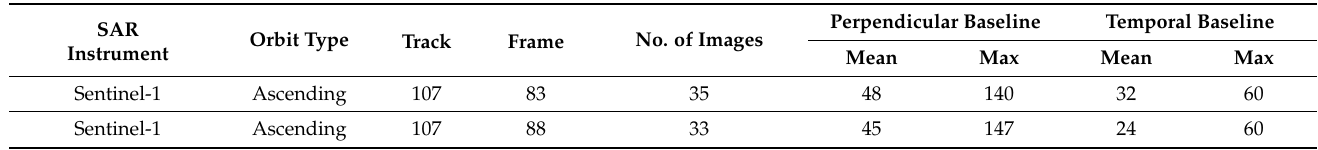
Table 1. Details of the persistent scatterer (PS) stacks used in mapping land deformation in the Texas Coastal Bend region. SAR Instrument